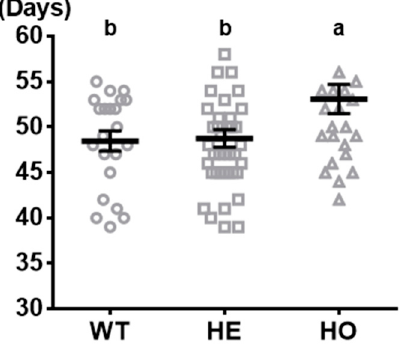
Figure 1. Comparison of first egg laying dates of wild-type (WT), MSTN heterozygous mutant quail (HE) and MSTN homozygous mutant quail (HO). Values present means ± SEM. n = 22 WT females, 40 HE females, and 25 HO females. One-way ANOVA was used for statistical analysis by the GraphPad PRISM. a,b Means that have no superscript in common in a graph are different ( p < 0.05).